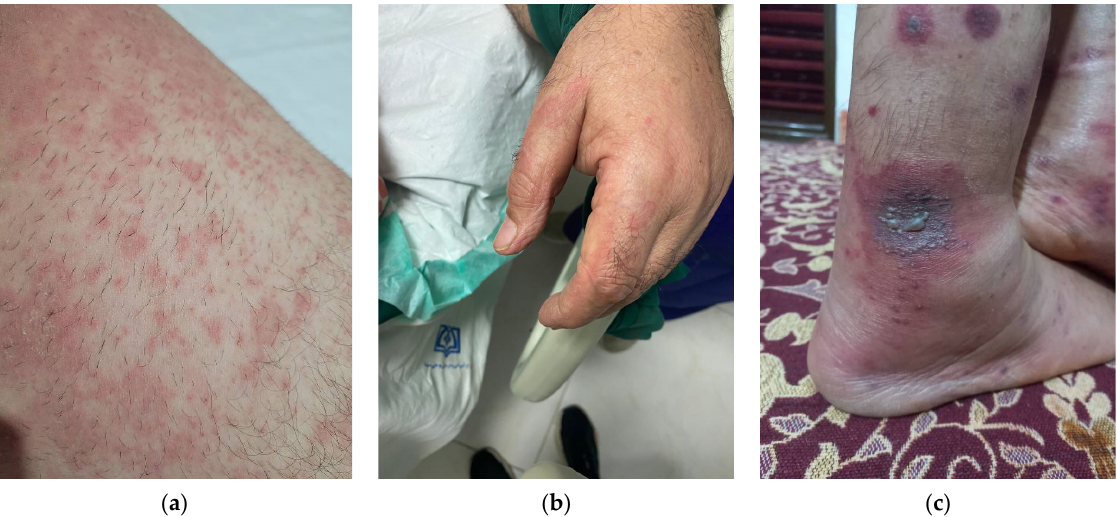
Figure 1. Cutaneous manifestations of COVID ‐ 19. ( a ) Papulo ‐ squamous lesions ( b ) wheal ( c ) petechia purpura and vasculitis.